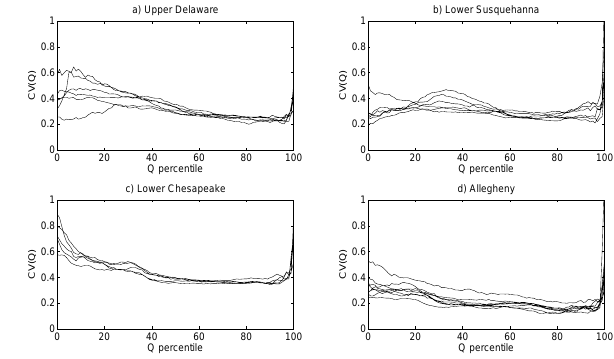
Fig. 5. Inter-annual coefficients of variation of streamflow per- centiles for all the 25 catchments within (a) Upper Delaware, (b) Lower Susquehanna, (c) Lower Chesapeake, and (d) Allegheny